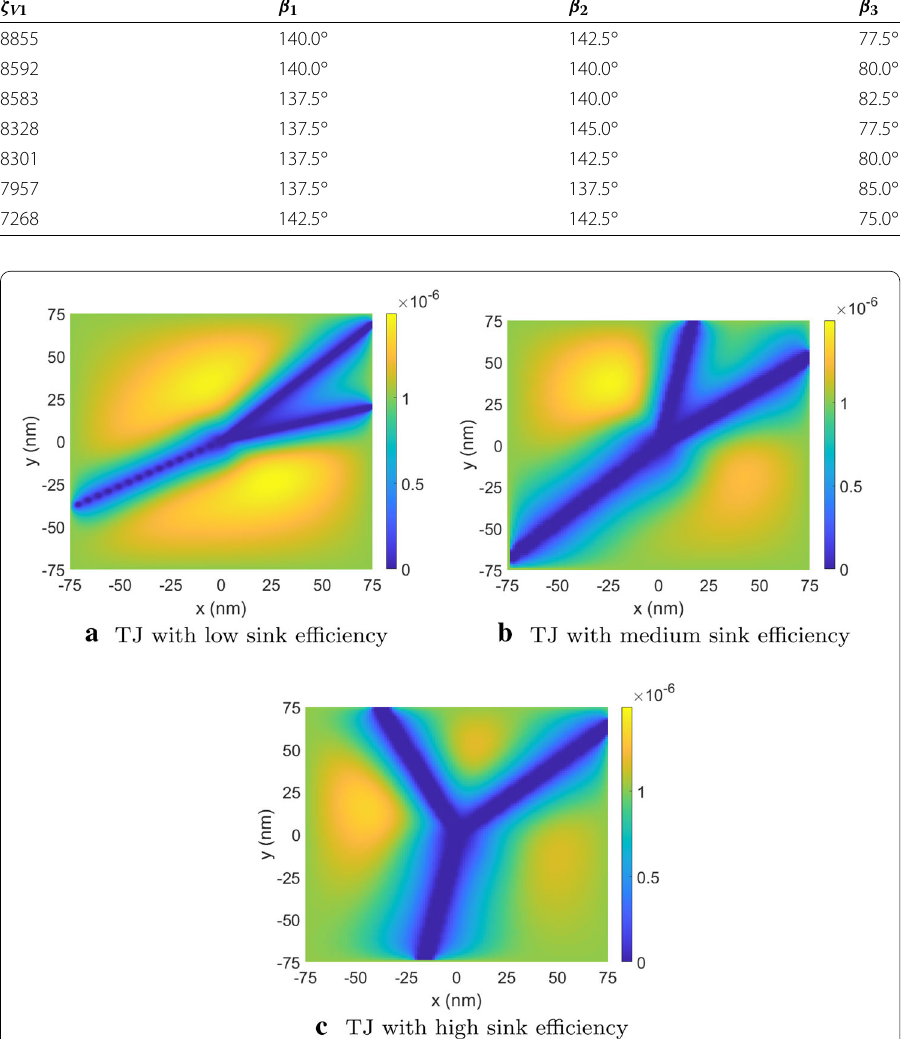
Fig. 3 Vacancy concentrations for three illustrative TJ configurations with different sink efficiencies. The TJ with low sink efficiency ( ζ V 1 = 2561) is indicated with a white diamond symbol in all the other sink efficiency plots, the TJ with medium sink efficiency ( ζ V 1 = 5542) is indicated with a white square symbol in sink efficiency plots, and the TJ with high sink efficiency ( ζ V 1 = 8855) is indicated with a white circle symbol in sink efficiency